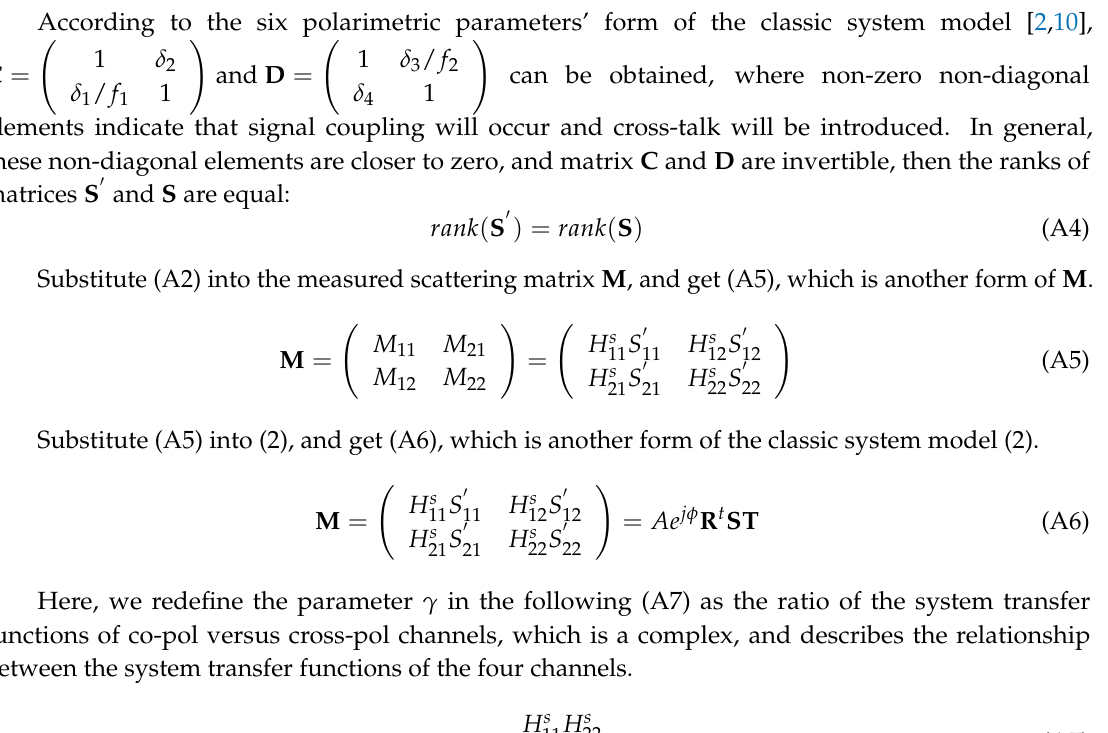
Figure A1. System transfer function model for radar